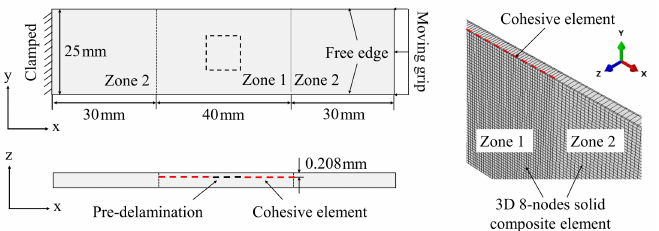
Figure 9. Finite element modeling, boundary and loading conditions for uniaxial compressive load. When the damage occurs, the damage evolution continues in the cohesive